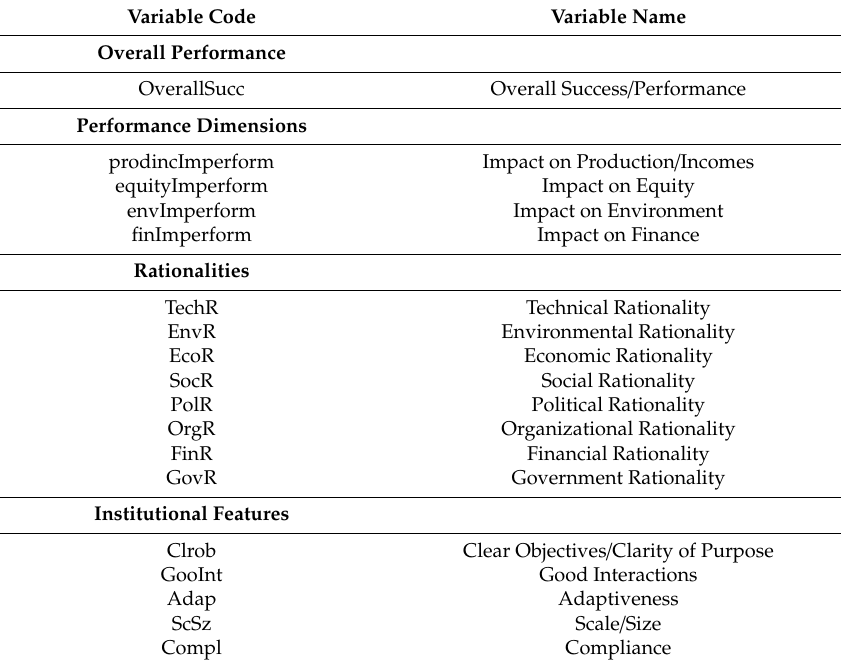
Table 2. List of variables used in the